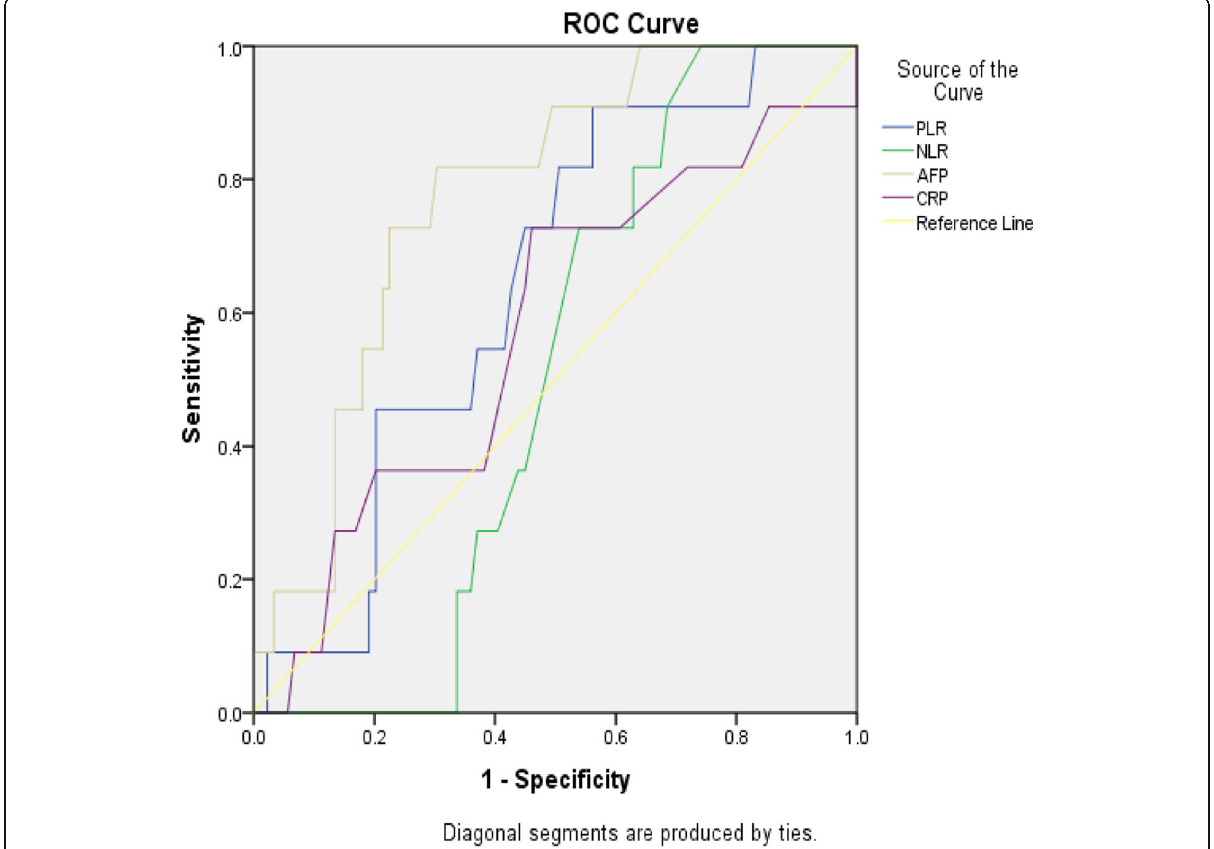
Fig. 2 Predictive ability of pre-transplantation AFP, CRP, PLR, and NLR for prediction of HCC